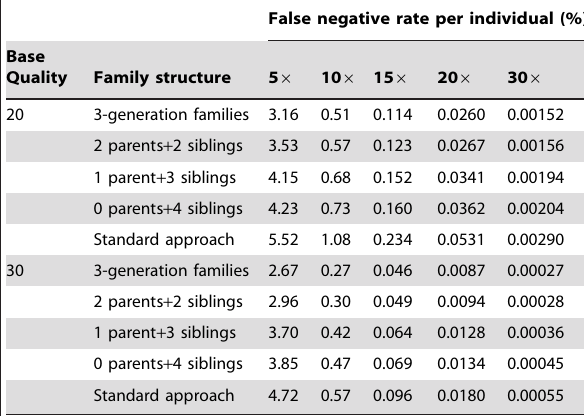
For all scenarios 300 sequenced individuals were simulated. doi:10.1371/journal.pgen.1002944.t001 inconsistency rate is 1.9*10 2 6 when family structure is modeled explicitly and 4.9*10 2 3 when treating individuals as unrelated (Table 3). Even at higher coverage and base quality scores, the rate of Mendelian inconsistencies in genotypes called without knowl- edge of family structure remains high (Table 3). Excluding markers